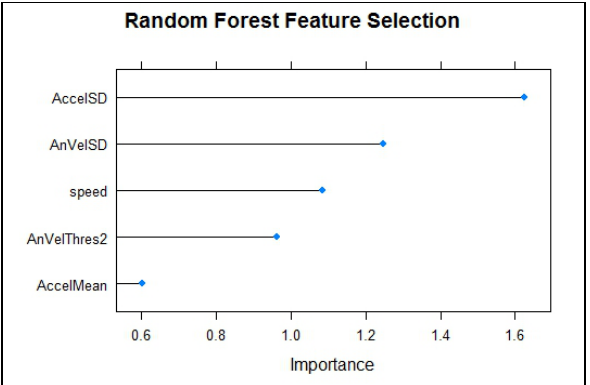
Figure 7 . Random Forest Feature